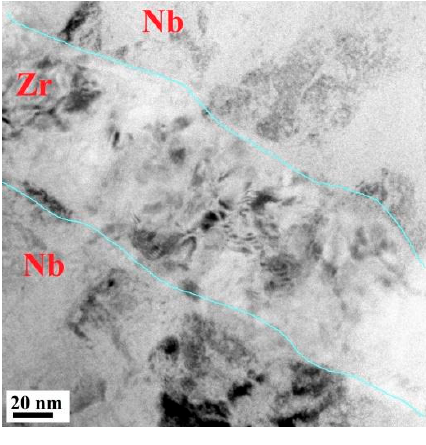
Figure 4. Cross-sectional bright-field TEM image showing the microstructure of the Zr/Nb multilayers ( a ) and the corresponding SAED ( b ).